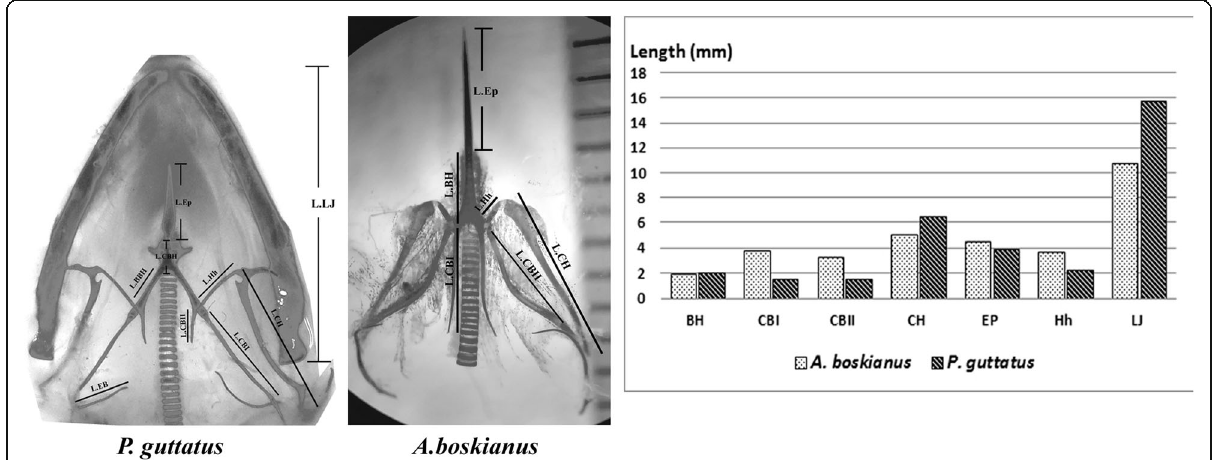
Fig. 5 Morphometrical characterization of each element of the hyoid apparatus of the two studied species. Means in millimeter, N =10. L.Ep, length of entoglossus process; L.BH, length of basihyoid; L.CBH, length of cartilaginous basihyoid; L.BBH, length of bony basihyoid; L.Hh, length of hypohyalis; L.CH, length of ceratohyalis; L.CBI, length of ceratobranchialis I; L.CBII, length of ceratobranchialis II; L.EB, length of